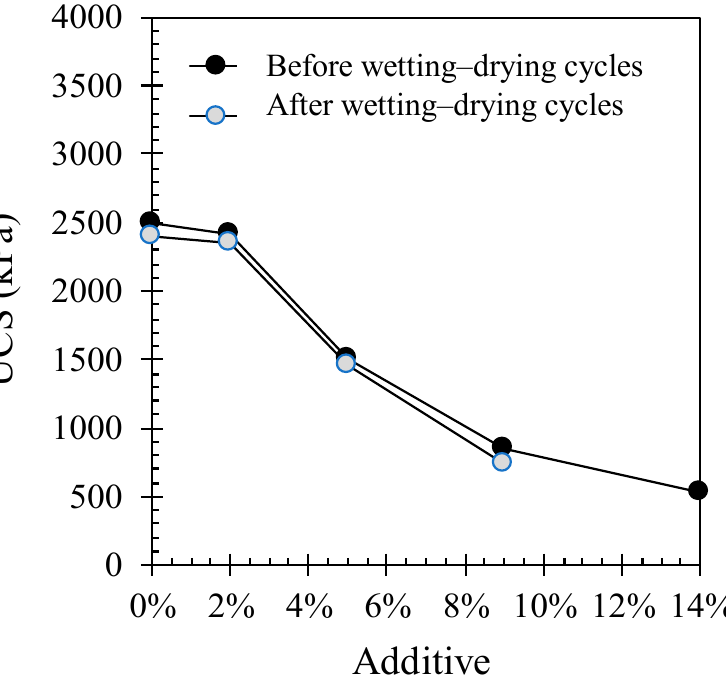
Figure 14. UCS as a function of additive content before and after wetting–drying cycles of lateritic soil.